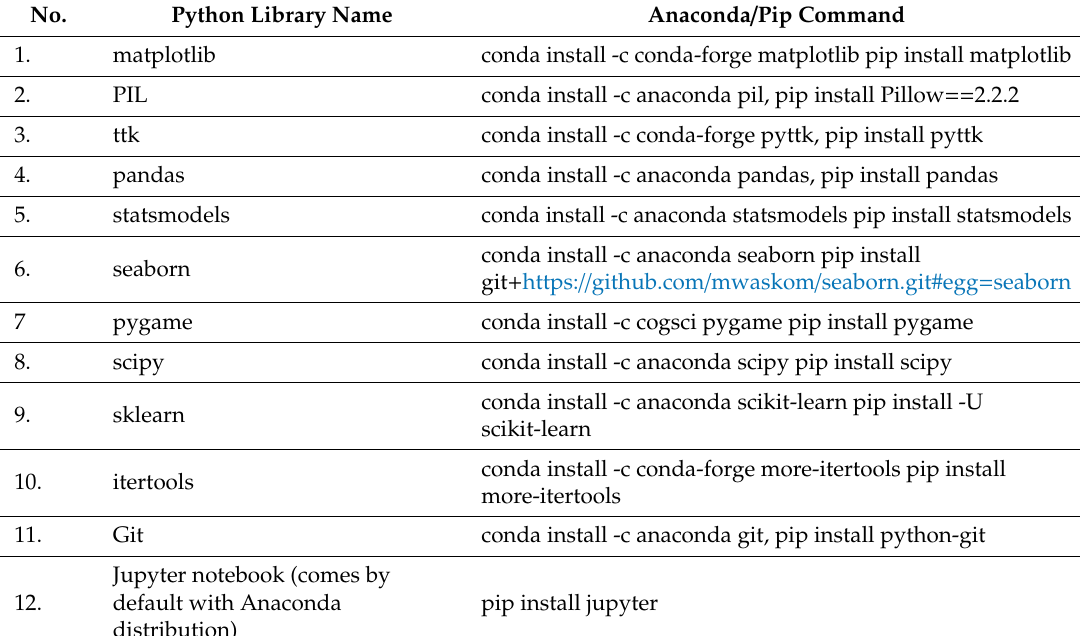
Table A1. Python libraries to be installed for using GazeVisual-Lib and their